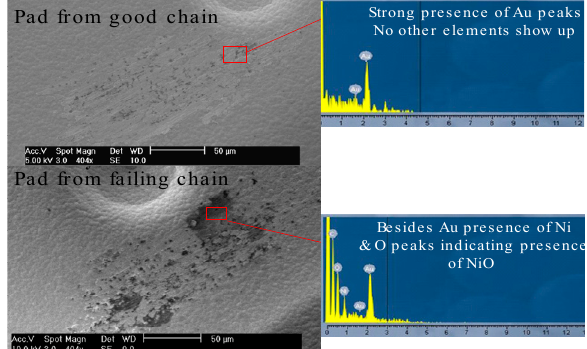
Figure 11. X-section of a failed chain.